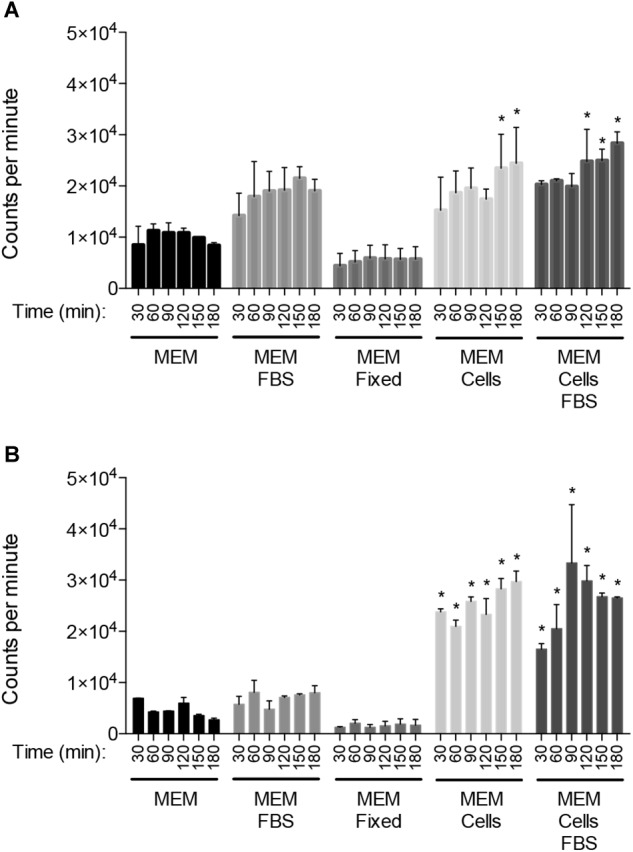
Co-cultivation of C. jejuni with viable epithelial cells stimulates enhanced metabolic activity. Temporal kinetics of [35S]-methionine incorporation by C. jejuni strains 81–176 (A) and F38011 (B) incubated in MEM, MEM plus 1% FBS, MEM with human INT 407 epithelial cells that had been fixed with paraformaldehyde, MEM with viable human INT 407 epithelial cells, and MEM plus 1% FBS and viable human INT 407 epithelial cells. The FBS used in these experiments was albumin-depleted and dialyzed against PBS. The [35S]-methionine labeling was performed in the presence of emetine hydrochloride to prevent radioactive methionine incorporation by the host cells. The bacteria were pelleted at the end of the time intervals indicated, washed in PBS, and amount of [35S]-methionine incorporation determined by measuring counts per minute following trichloroacetic acid (TCA) precipitation. Shown is the mean ± the standard deviations. Significant differences from the MEM alone at each time point were determined by one-way ANOVA followed by Sidak’s multiple comparisons test (∗p < 0.05).